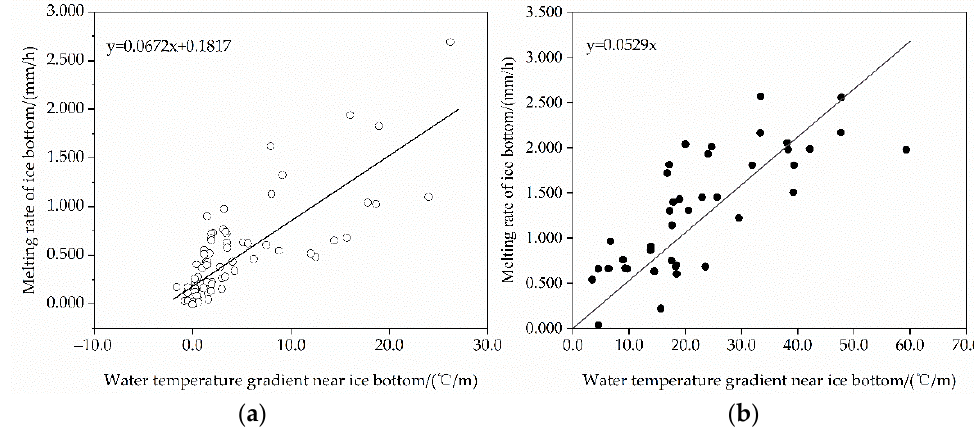
Figure 7. The statistical relationship between the surface melting rate and air temperature gradient.